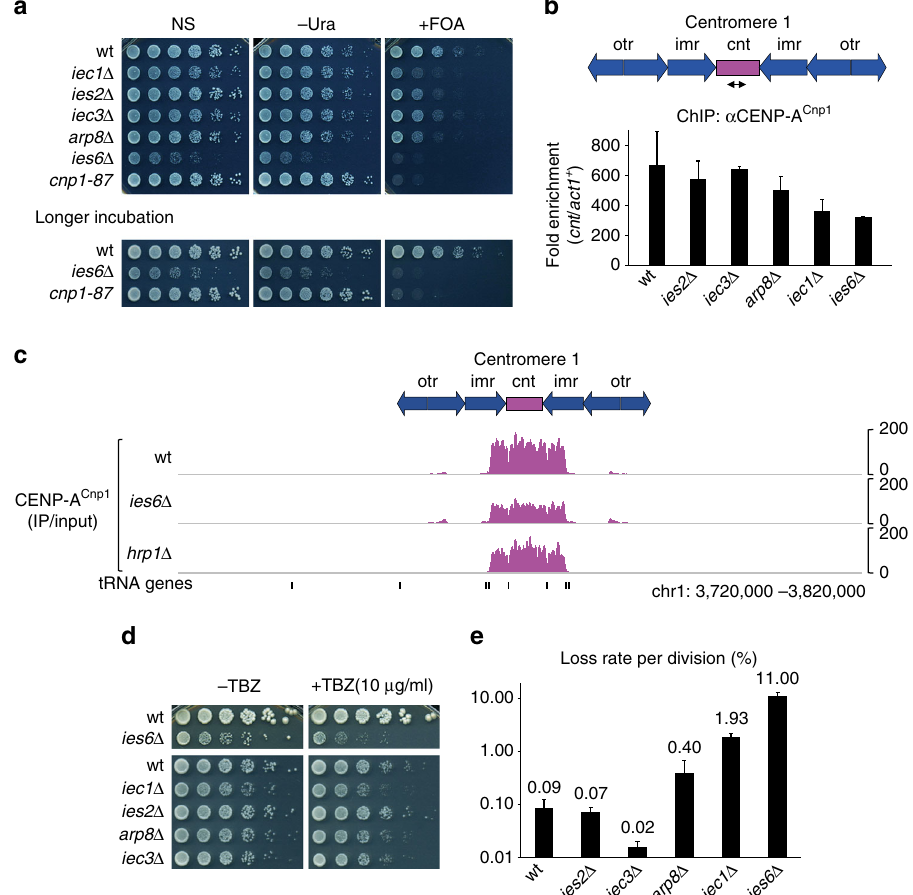
Fig. 1 Defects in the Ino80 complex impair assembly and function of centromeric chromatin. a Silencing of ura4 + inserted at centromere 1 ( cnt1 : ura4 + ) of wild-type (wt) and those harboring mutants of the Ino80 complex. The ies6 Δ , wt, and CENP-A Cnp1 mutant ( cnp1-87 ) cells were incubated for one additional day (denoted by “ longer incubation ” ) to ensure full growth. Serial dilutions ( fi vefold) of cells were spotted onto non-selective (NS), uracil-depleted ( − Ura), or FOA-containing (+FOA) medium at 30 °C. FOA was used to kill ura4 + -expressing cells. b Schematic of centromere 1 ( top ), indicating the central core ( cnt ), innermost repeat ( imr ), and outer repeats ( otr/dg-dh ). The primer pairs corresponding to cnt are indicated below. ChIP analysis for CENP-A Cnp1 in the indicated cells grown at 30 °C (bottom). Fold enrichment was calculated by comparing the cnt / act1 + ratio between the IP and input DNA. Data indicate the mean ± s.d. ( error bars ) of three biological replicates. c Genome browser view of centromere 1 showing the ChIP-Seq pro fi les of CENP-A Cnp1 . Fold enrichment represents IP relative to input. d TBZ sensitivity of cells grown with no TBZ ( − TBZ) or with 10 μ g ml − 1 TBZ. e Minichromosome loss assay monitoring the loss of non-essential chromosome 16 (Ch16) during cell division. Cells (618 – 4,837) from three independent colonies for each strain were analyzed to estimate the proportion of cells in the colony containing the minichromosome (see Methods for more detail). Data indicate the mean loss rate ± s.d. ( error bars